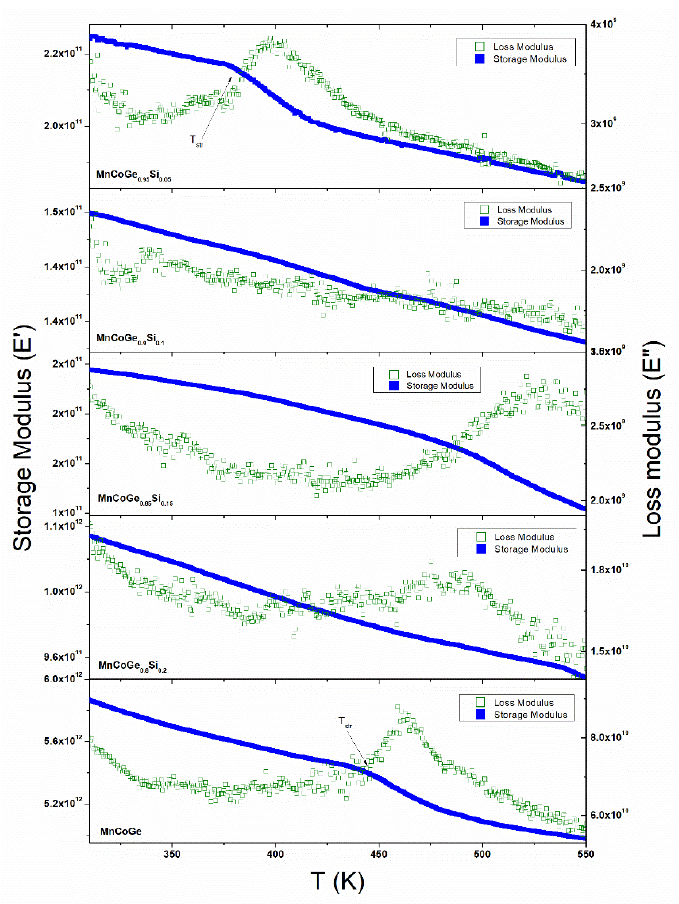
Figure 5. Storage modulus (E’) and loss modulus (E”) measured for MnCoGe 1−x Si x (x = 0, 0.05, 0.1, 0.15, and 0.2).